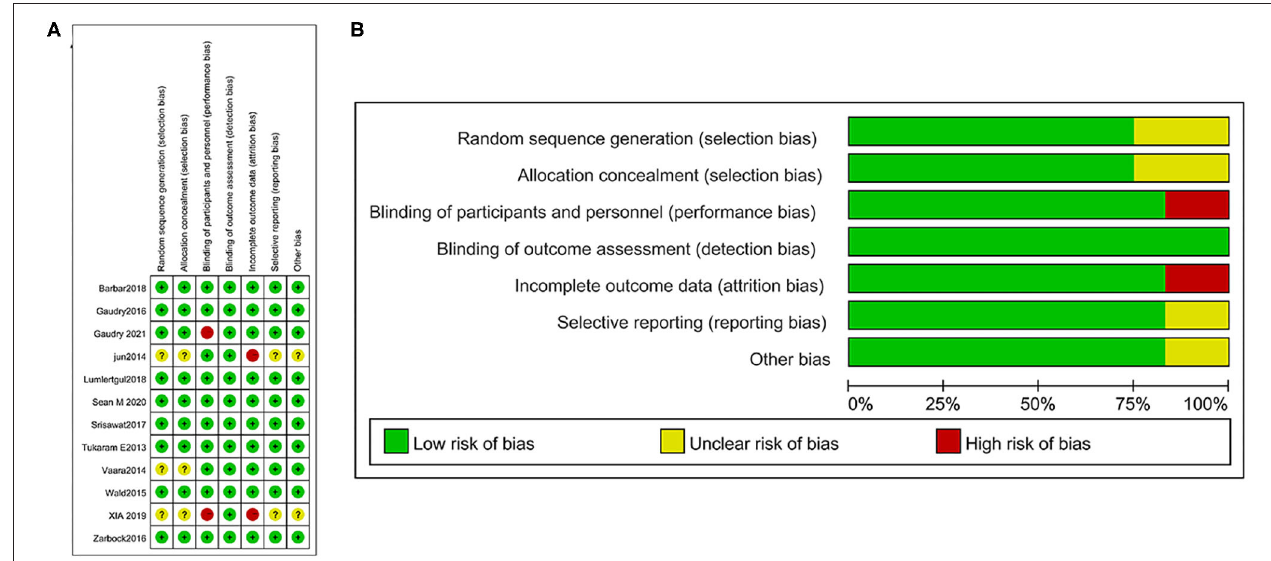
FIGURE 2 | Risk of bias summary: a review of authors’ judgments concerning the risk of bias in the included studies (A) and risk of bias graph: a review of authors’ judgments about each risk of bias item presented as percentages across all included studies (B) .